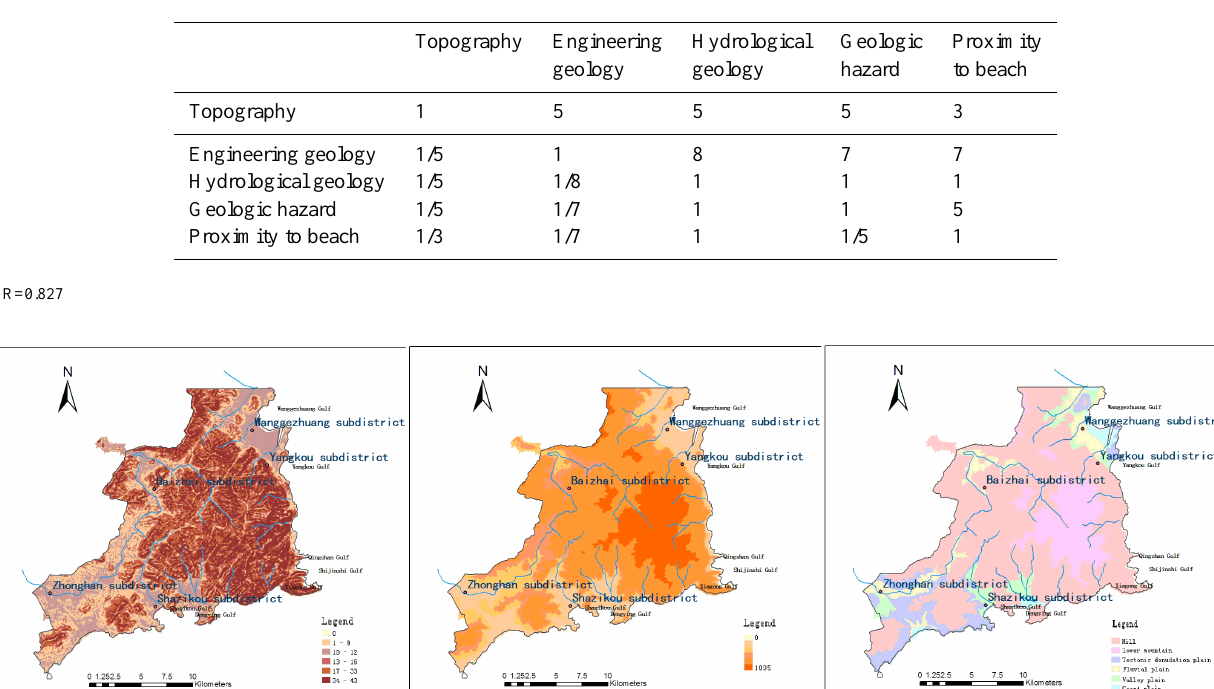
Table 3. Comparison matrix for main criteria.